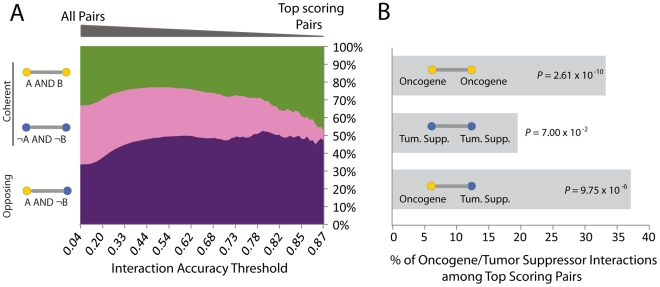
Network functions underlying cancer progression.(A) The decision trees for mesenchymal transformation are dissected by assigning their gene pairs to one of three functional categories based on the sign of gene expression in predicting the more aggressive phenotype. The percentage of gene pairs assigned to each of the three functional categories is shown as a function of the score threshold used for selecting gene pairs. Accuracy is calculated as the average Laplace score (Text S1) over all trees in the forest. (B) Enrichment for interactions between oncogenes, between tumor suppressors and between an oncogene and a tumor suppressor among functional categories identified using NGF. Percent of such interactions among top scoring pairs in each functional category is reported along with the Fisher's Exact Test P-value of enrichment.